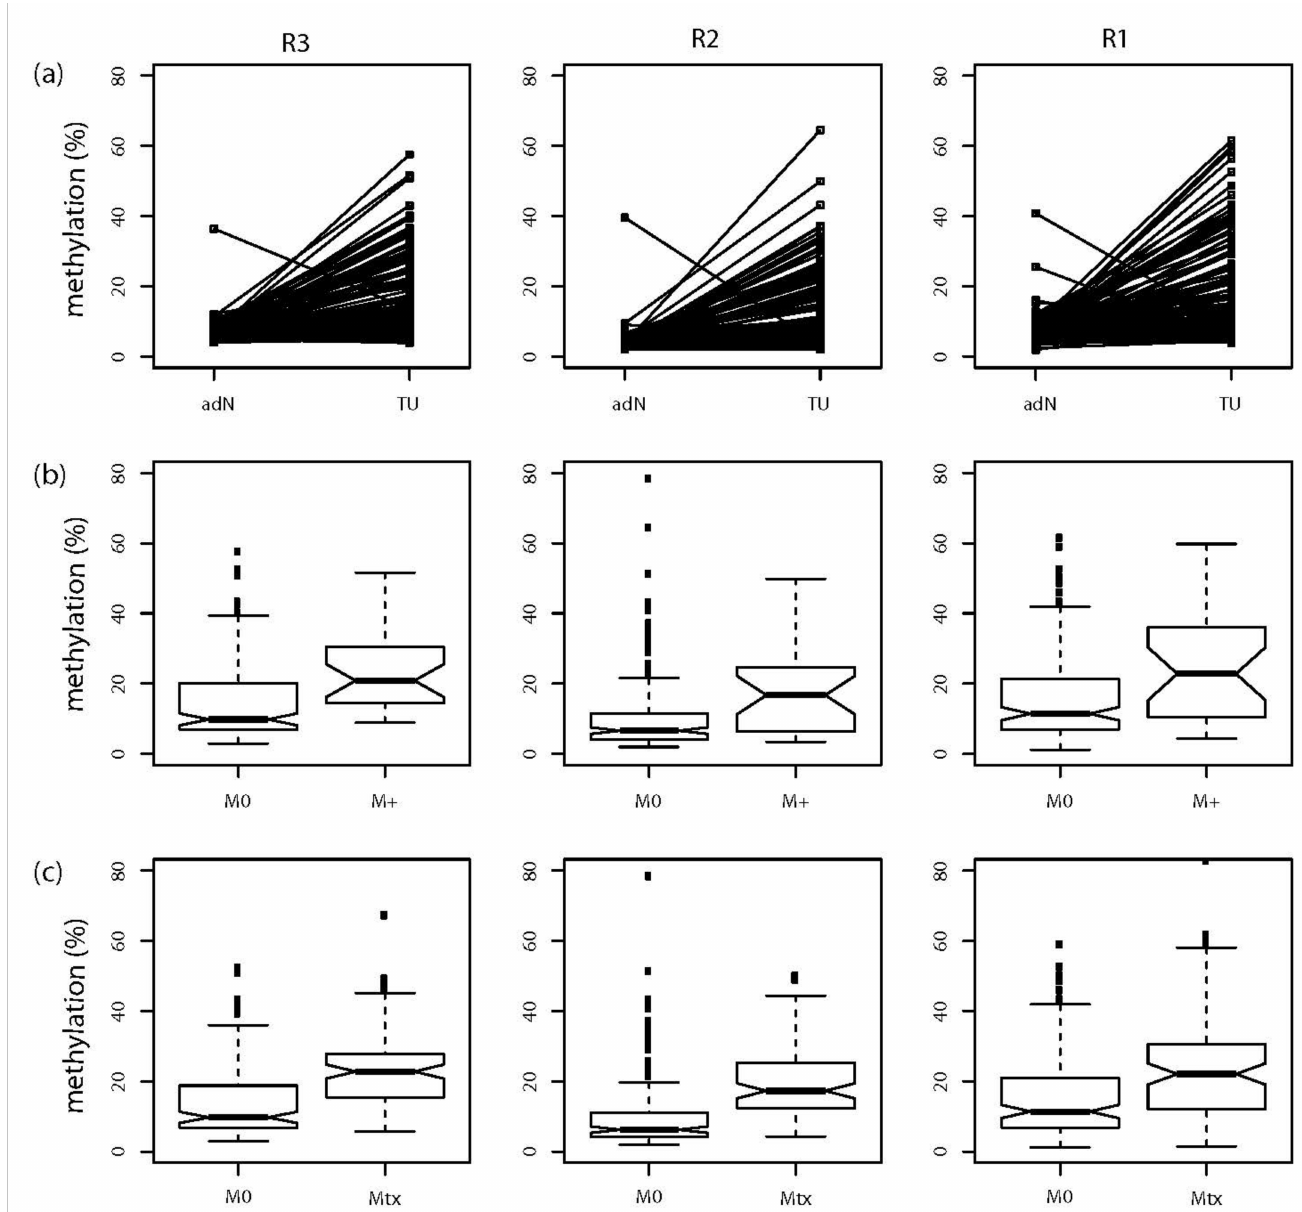
Figure 4. Tumor-specific, state of distant metastasis-specific, and metastatic tissue-specific hyper- methylation in NKX6-2 regions R3-R1. ( a ) Strip chart presentation of hypermethylation analysis of regional methylation in NKX6-2 R1-R3 in paired adjacent normal tissue (adN) and renal tumor (TU) tissues. Corresponding statistical analysis showed significant tumor-specific hypermethylation for the R1, R2, and R3 regions (all p < 1.25 × 10 − 14 , for statistical results see Table 2). ( b ) Box plot of average methylation in regions R3-R1 in NKX6-2 in tumors without (M0) and with metastatic disease (M+). Medians, notches showing the estimated confidence interval, 25% and 75% quartiles, whiskers indicating the 99.3% interval (two-sided 1.5-fold of interquartile range), and outliers (black squares) of the relative methylation distributions are shown. All p ≤ 0.008 (for statistical results see Table 2). ( c ) Box plot of methylation in NKX6-2 regions R1–R3 comparing localized primary tumor tissue (M0) and metastatic tissue samples (Mtx). All regions demonstrate metastatic tissue-specific hypermethylation (all p ≤ 1.04 × 10 − 5 , for statistical results see Table 2). Box plot presentation as described in ( b